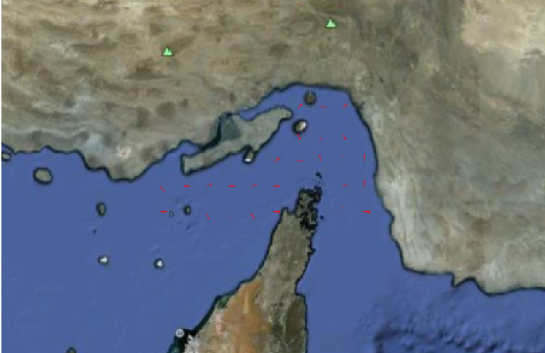
Figure 6. Surface current vector field Over the Coastal area of Hormuz Strait in an overall view and low resolution and vector